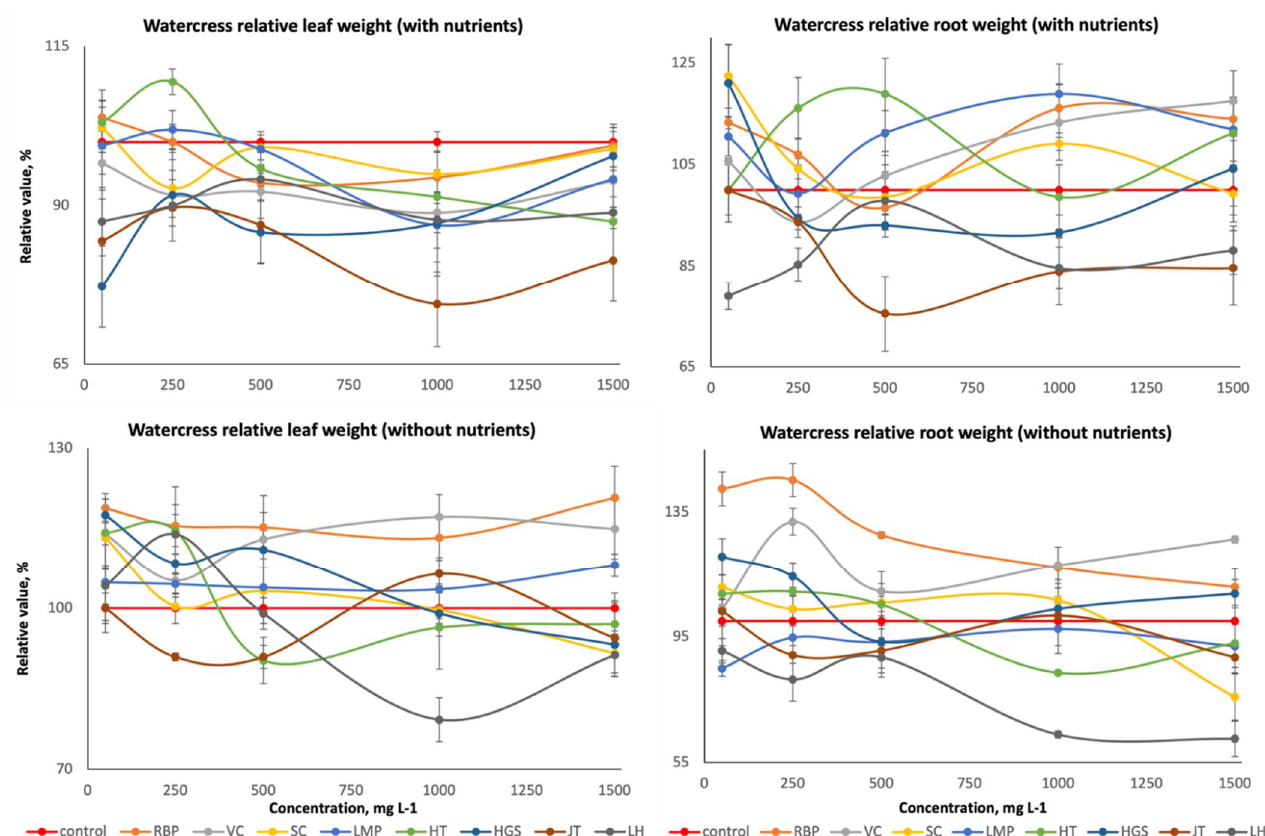
Figure 4. Relative changes in watercress ( Lepidium sativum ) shoot and root weight over a concentration range of potassium humate solutions of different origins, with and without added nutrient solution. RBP = raised bog peat, VC = vermicompost, SC = soil compost, LMP = low moor peat, HT = Humin Tech potassium humate, HGS = Humic Growth Solutions potassium humate, JT = Jin Tai FA, LH = Lignohumate